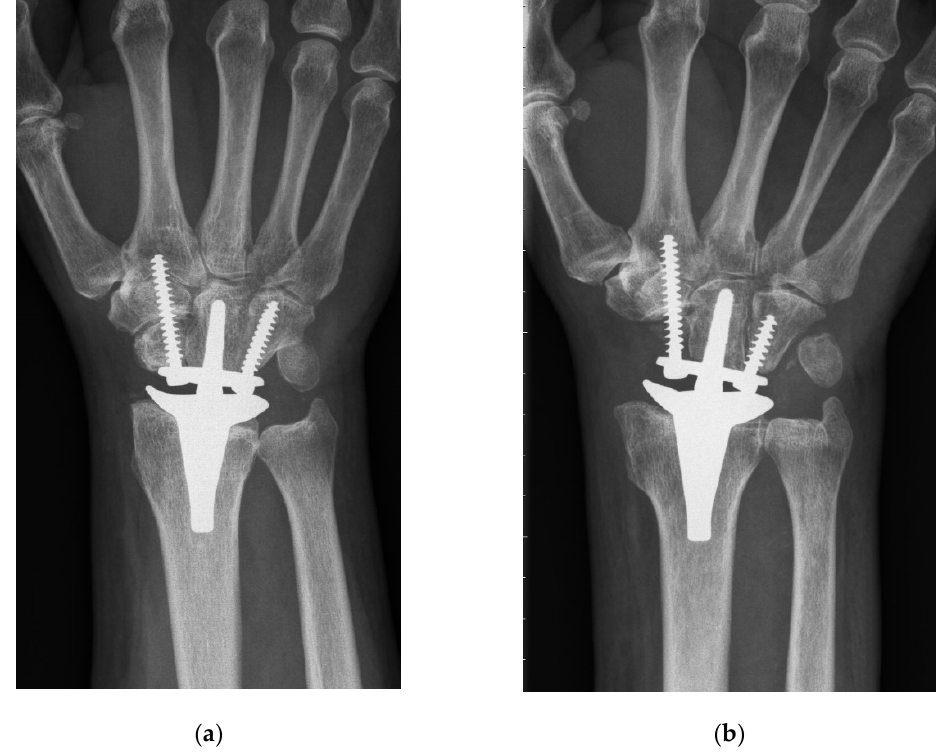
Figure 1. Postoperative radiograph showing both applied implantation techniques: ReMotion implantation using ( a ) CCR (conventional carpal resection) and ( b ) PRC (proximal row carpectomy). The results merely differ in the distal pole of the scaphoid being removed in the PRC cohort.